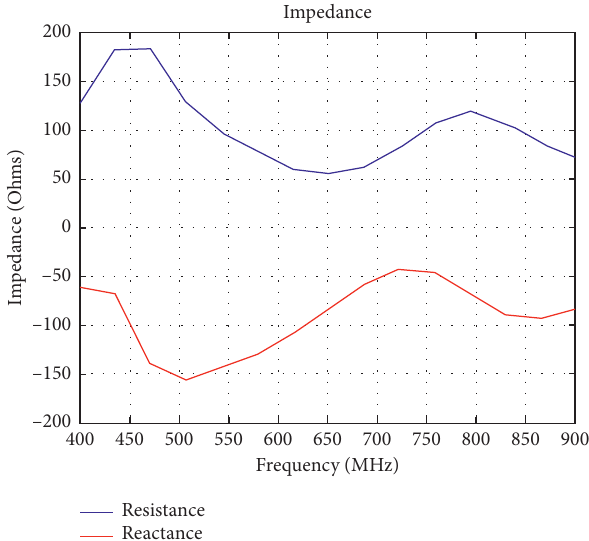
Figure 14: One-iteration fractal Koch antenna impedance along the bandwidth.